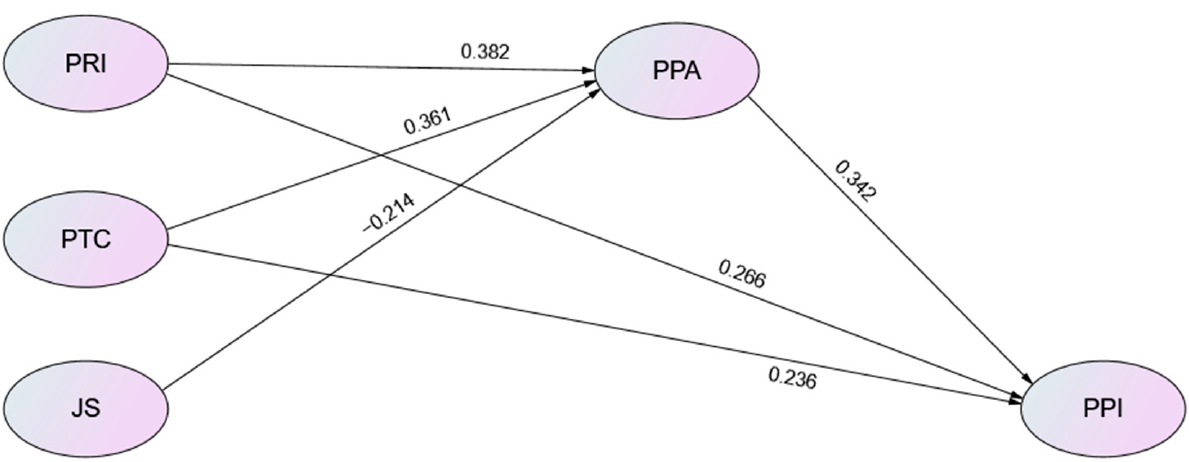
Figure 2. SEM Statistical Model of Path analysis results. Note: PPA = Pandemic Prevention Attitude; PPI = Pandemic Prevention Intention.; PRI = Perceived Risk of Infection; JS = Job Stress; PTC = Pandemic Prevention IT Convenience.